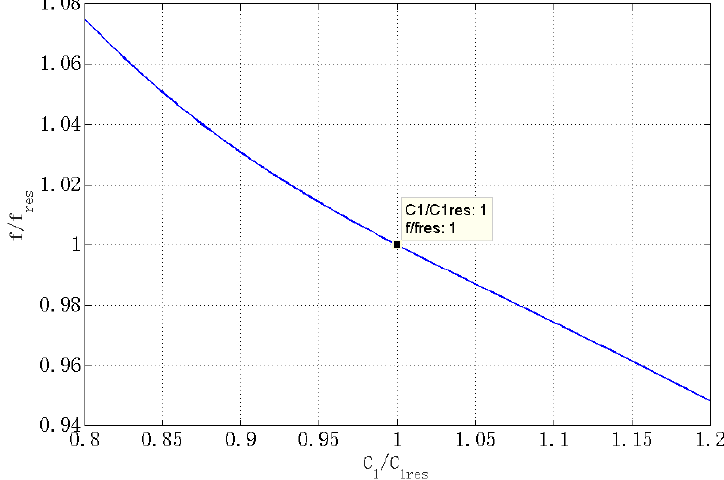
Figure 7. Function f ( C 1 ).